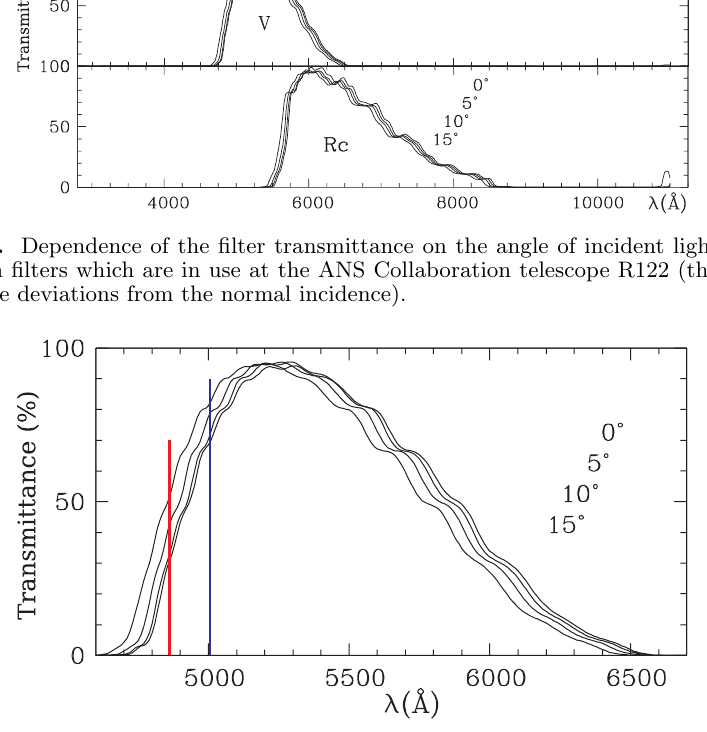
Fig. 7. Zooming on the V passband filter of Figure 6. The two vertical lines mark positions of the H (cid:12) and [OIII] 5007 ˚A